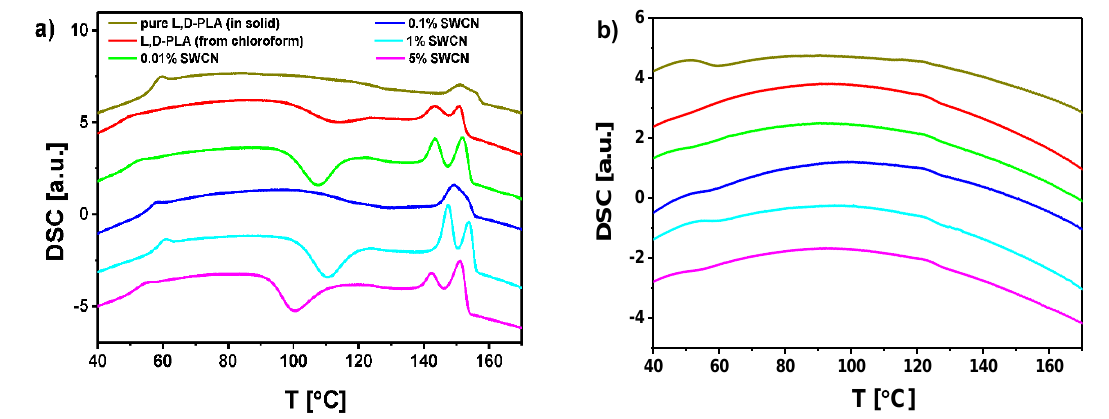
Figure 4. DSC curves registered for L , D -PLA and its mixtures with SWCN on heating ( a ) and cooling ( b ) at a rate of 5 °C/min.